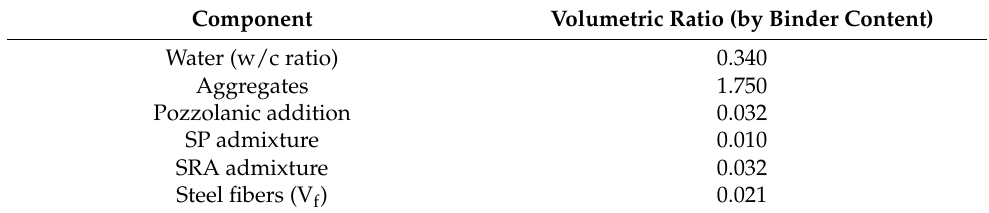
Table 1. HPFRC composition in terms of the volumetric ratio with respect to the binder content.